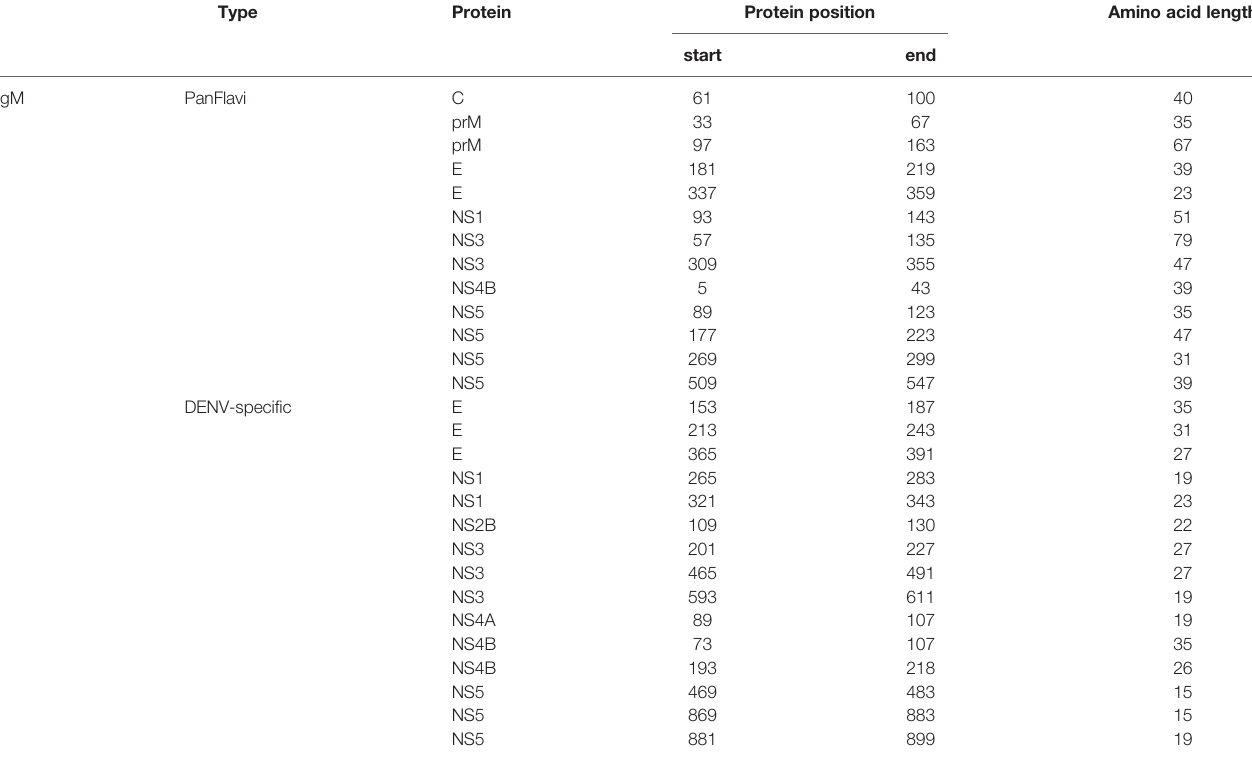
TABLE 3 | Most reactive IgM peptides selected by the high-density